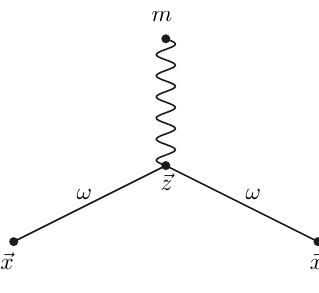
Figure 3 . Leading order potential graviton correction to bulk scalar Feynman